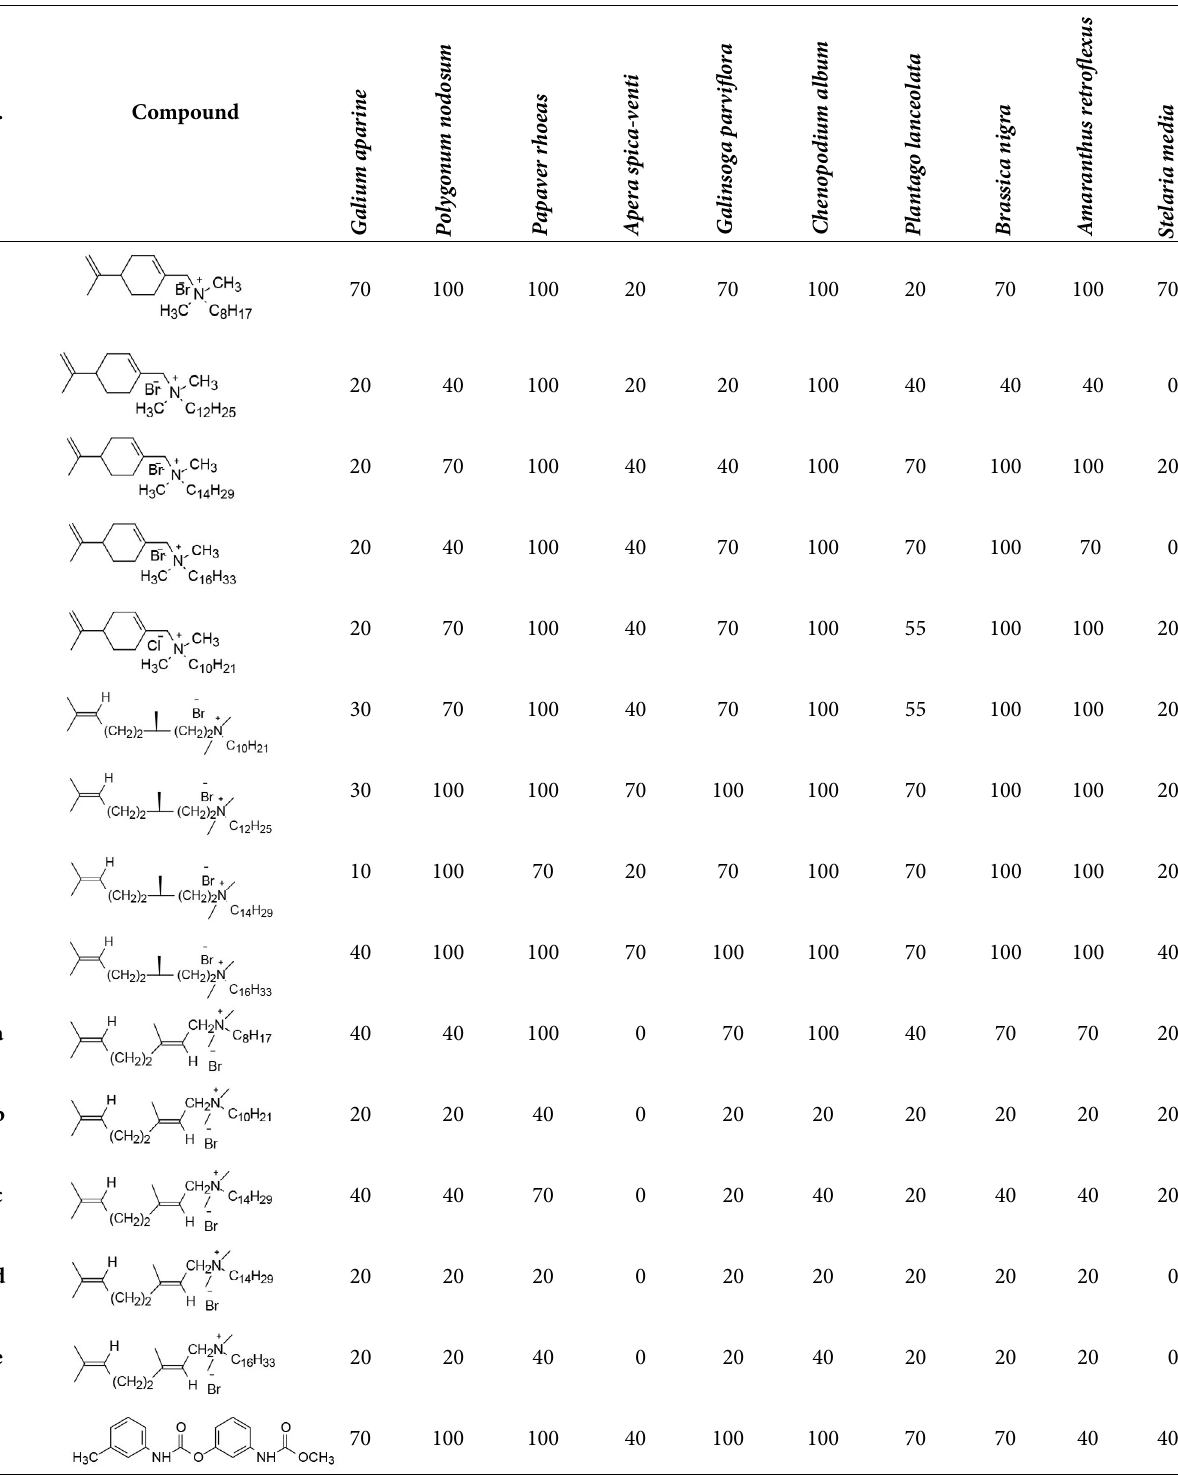
Table 3. Herbicidal activity of quaternary ammonium salts 4a – h , 7a – e and 10a – e (dose: 2 kg/ha)